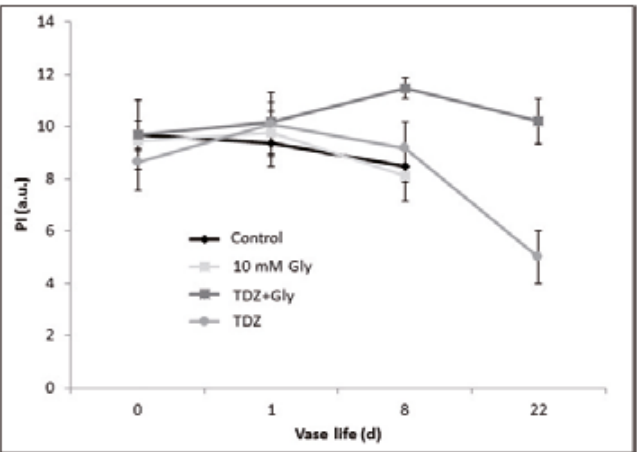
Fig. 3 - Performance index (PI) measured on cut foliage during vase life determination. Values are means with standard errors ( n =5).